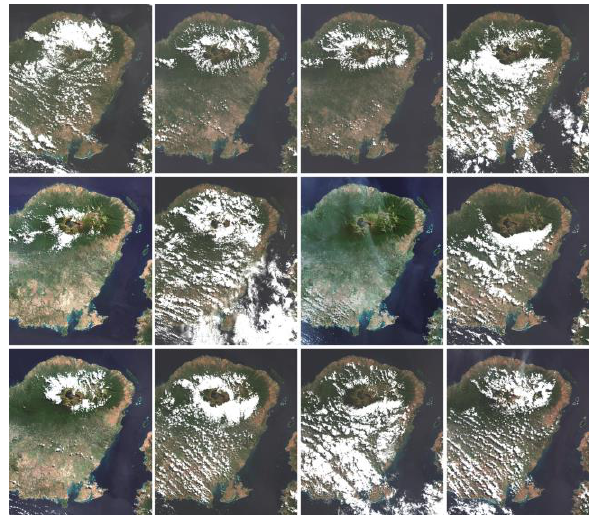
Figure 2. Sentinel-2 MSI dataset for PRE-disaster observation. From top left, to bottom right image: May 28; June 02, 07, 12, 17, and 22; July 02, 07, 12, 17, and 27; August 01,